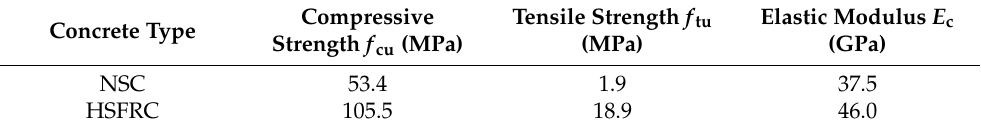
Table 3. Material property of